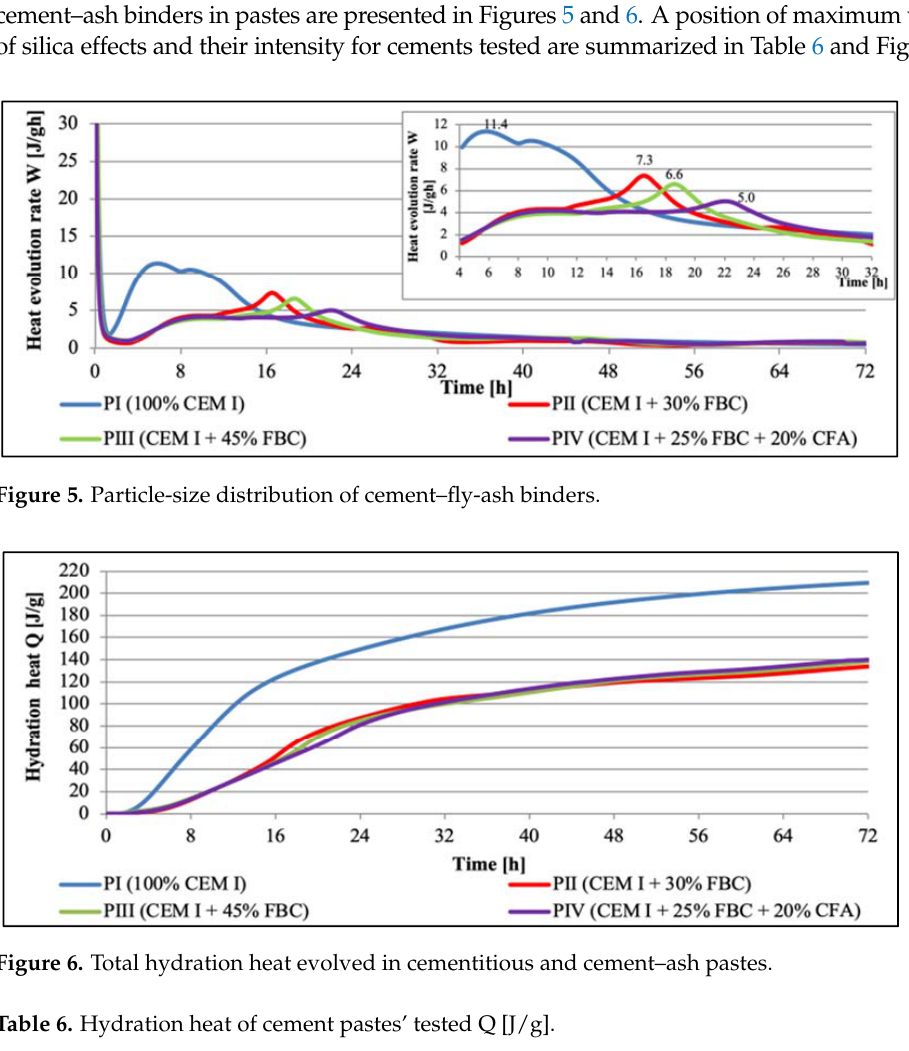
Table 6. Hydration heat of cement pastes’ tested Q [J/g].